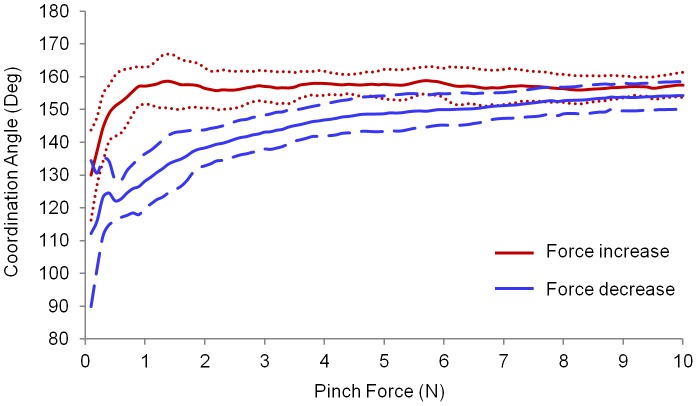
Coordination angles of the two force vectors at different pinch force magnitudes during increasing and decreasing force conditions.The solid lines represent the average of CA across all trials. The dotted/dashed lines represent the plus/minus standard deviations of CA for all trials.